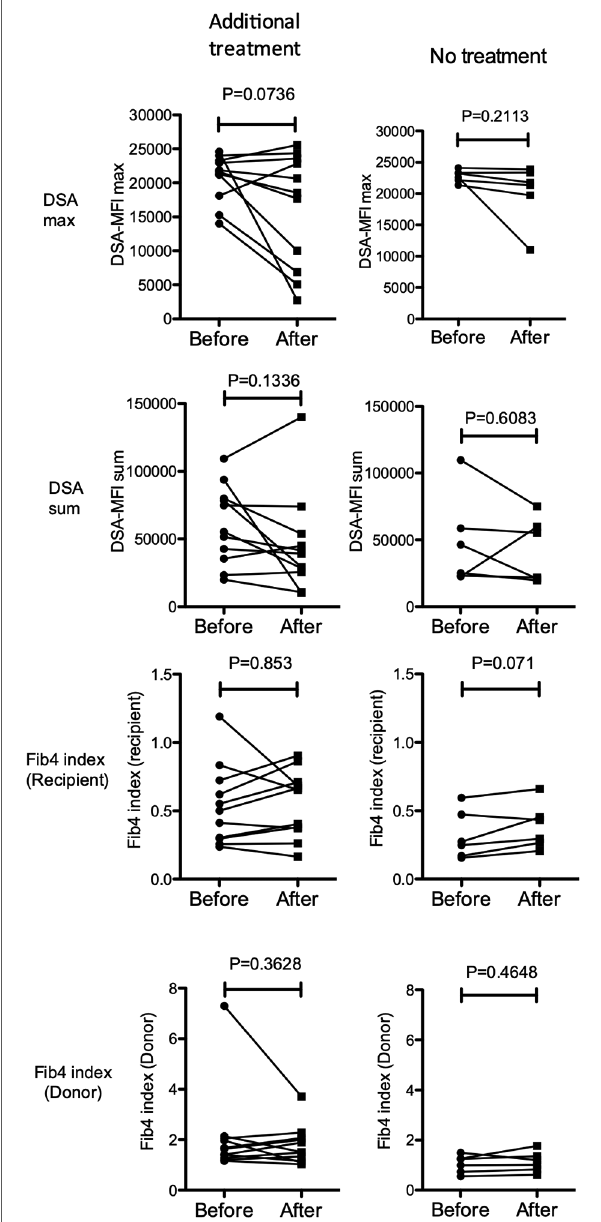
FIGURE 4 Changes in the maximum (top row) and sum (second row) of the DSA- MFI, Fib-4 indexes calculated by ages of the recipient (3rd row) and donor (4th row) after treatments with (left column, n =11) or without (right column, n =6) additional immunosuppressants for pediatric LT recipients with a high DSA-MFI and low fi brosis ( n =17). Paired t